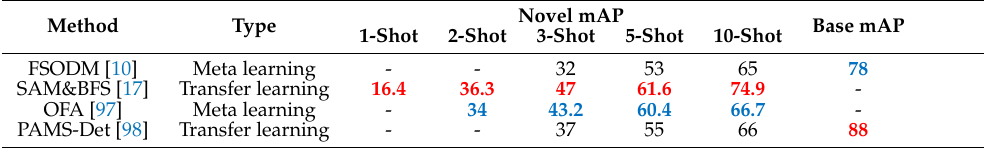
Table 3. FSOD performance (AP50 in %) on the base and novel classes of the NWPU VHR-10 dataset . Novel classes are airplane, baseball diamond, and tennis court. Base classes are the remaining ones. Red and blue indicate the state-of-the-art and the second-best performance,